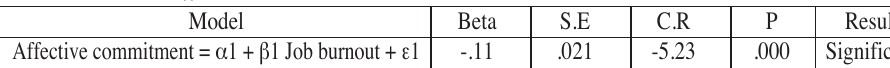
Job Burnout and Affective Commitment